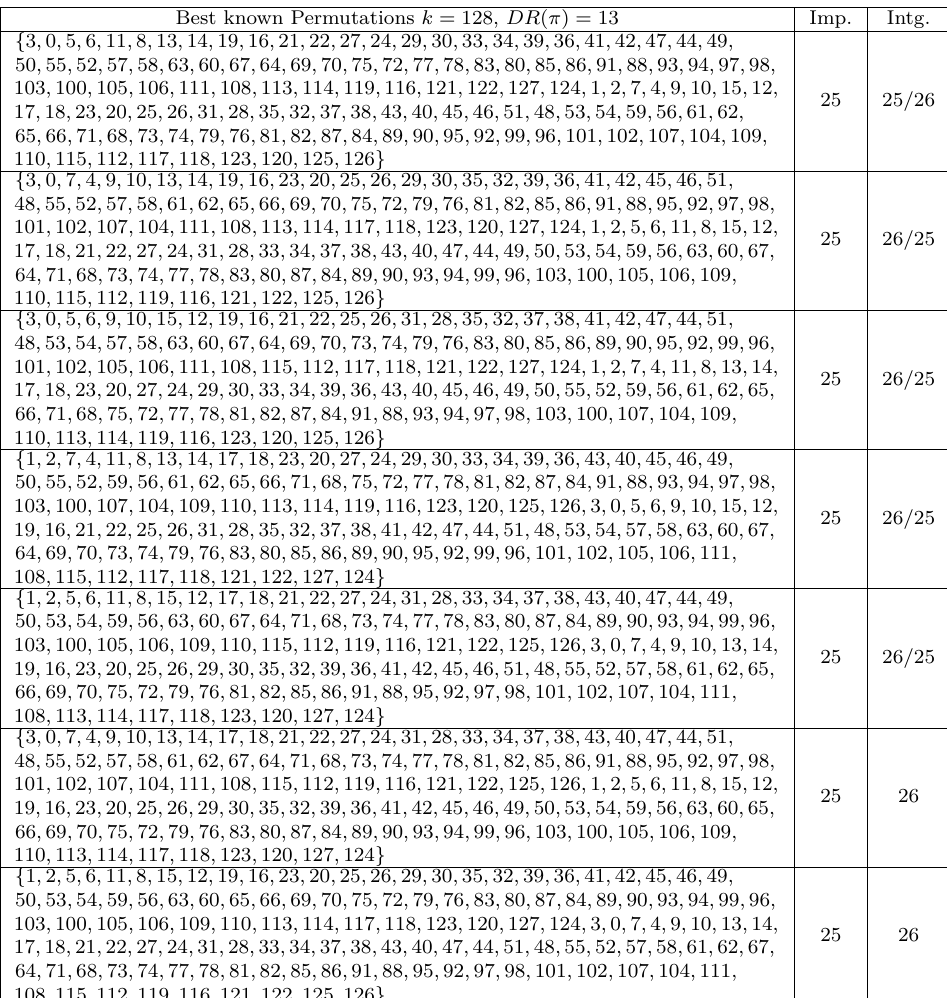
Table 25: Best known permutations k = 128 (continued) Best known Permutations k = 128, DR ( π ) =